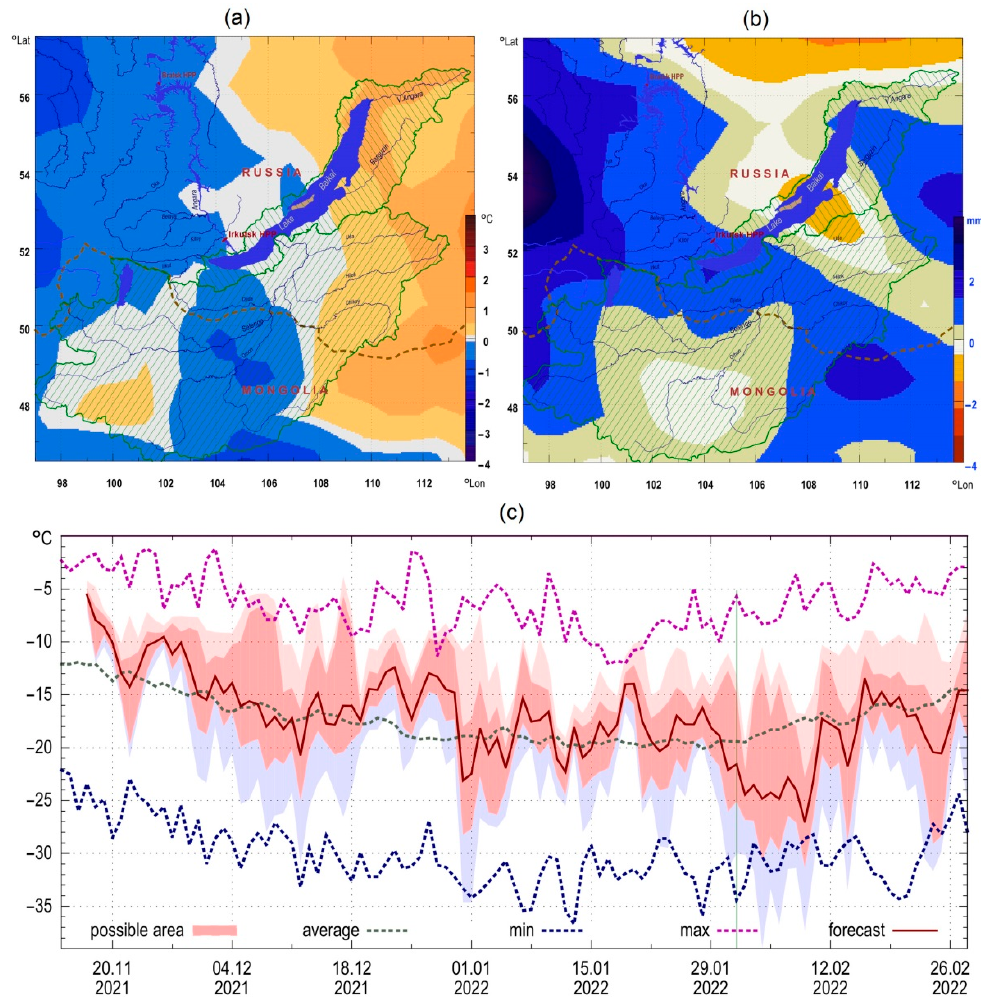
Figure 3. Examples of prognostic indicators creation for the winter period 2021–2022 (shaded lines show catchment areas of the Selenga River and part of Lake Baikal): ( a ) distribution of deviations from the average surface temperatures in February 2022; ( b ) the likely anomalies of precipitation intensities in February 2022; ( c ) the dynamics of changes in the temperature conditions in comparison with the actual average, minimum, and maximum average daily indicators for the area of Kyakhta (50.37° N, 106.40 ° E).